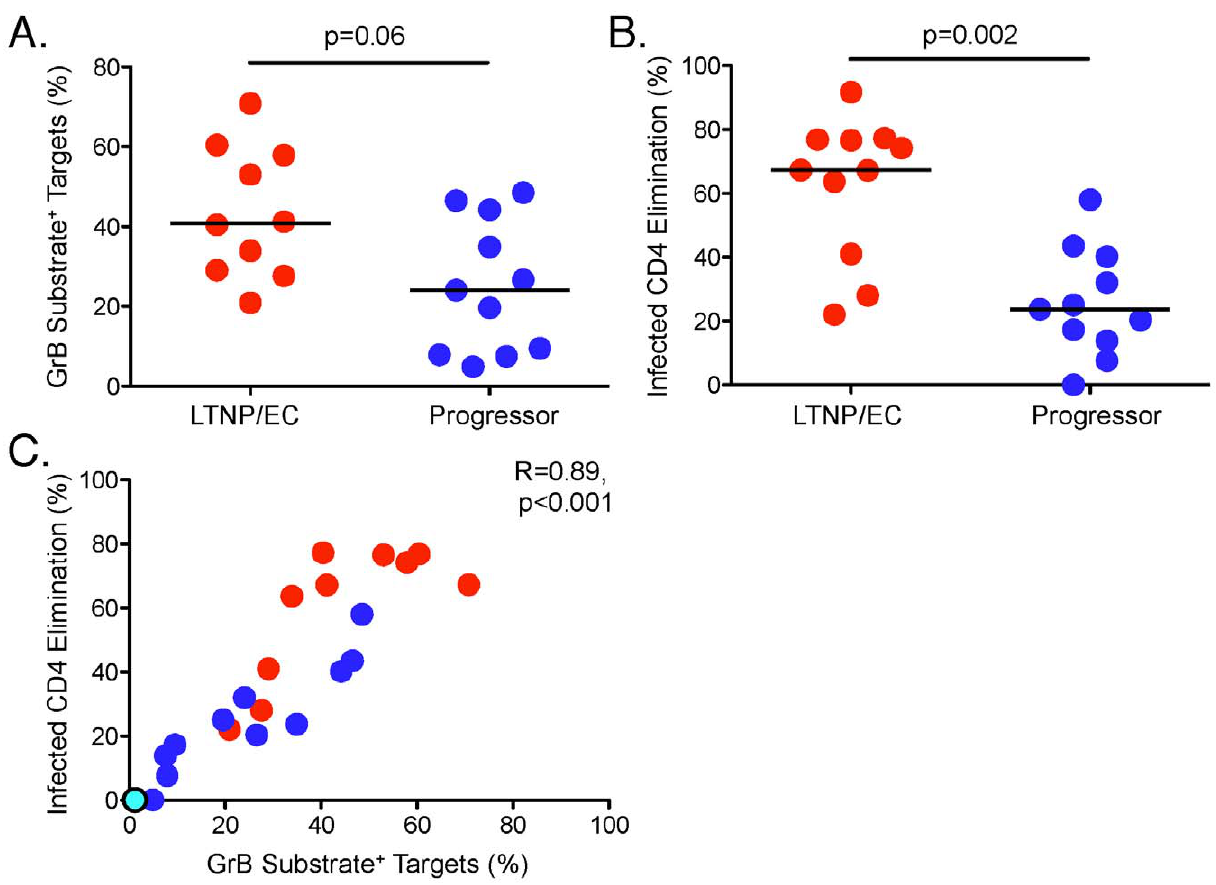
Figure 2. SIV-specific CD8 + T cells from LTNP/EC mediate greater lysis of SIV-infected CD4 + T-cell targets compared with progressors. GrB target cell activity ( A ) and infected CD4 elimination (ICE) ( B ) are shown for LTNP/EC (n=10, GrB target cell activity; n=11, ICE) and progressors (n=11). Horizontal bars represent the median values. C. Correlation between ICE and GrB target cell activity (n=22) was determined by the Spearman rank method. Red, blue and cyan dots represent LTNP/EC, progressors and one SIV-uninfected animal,